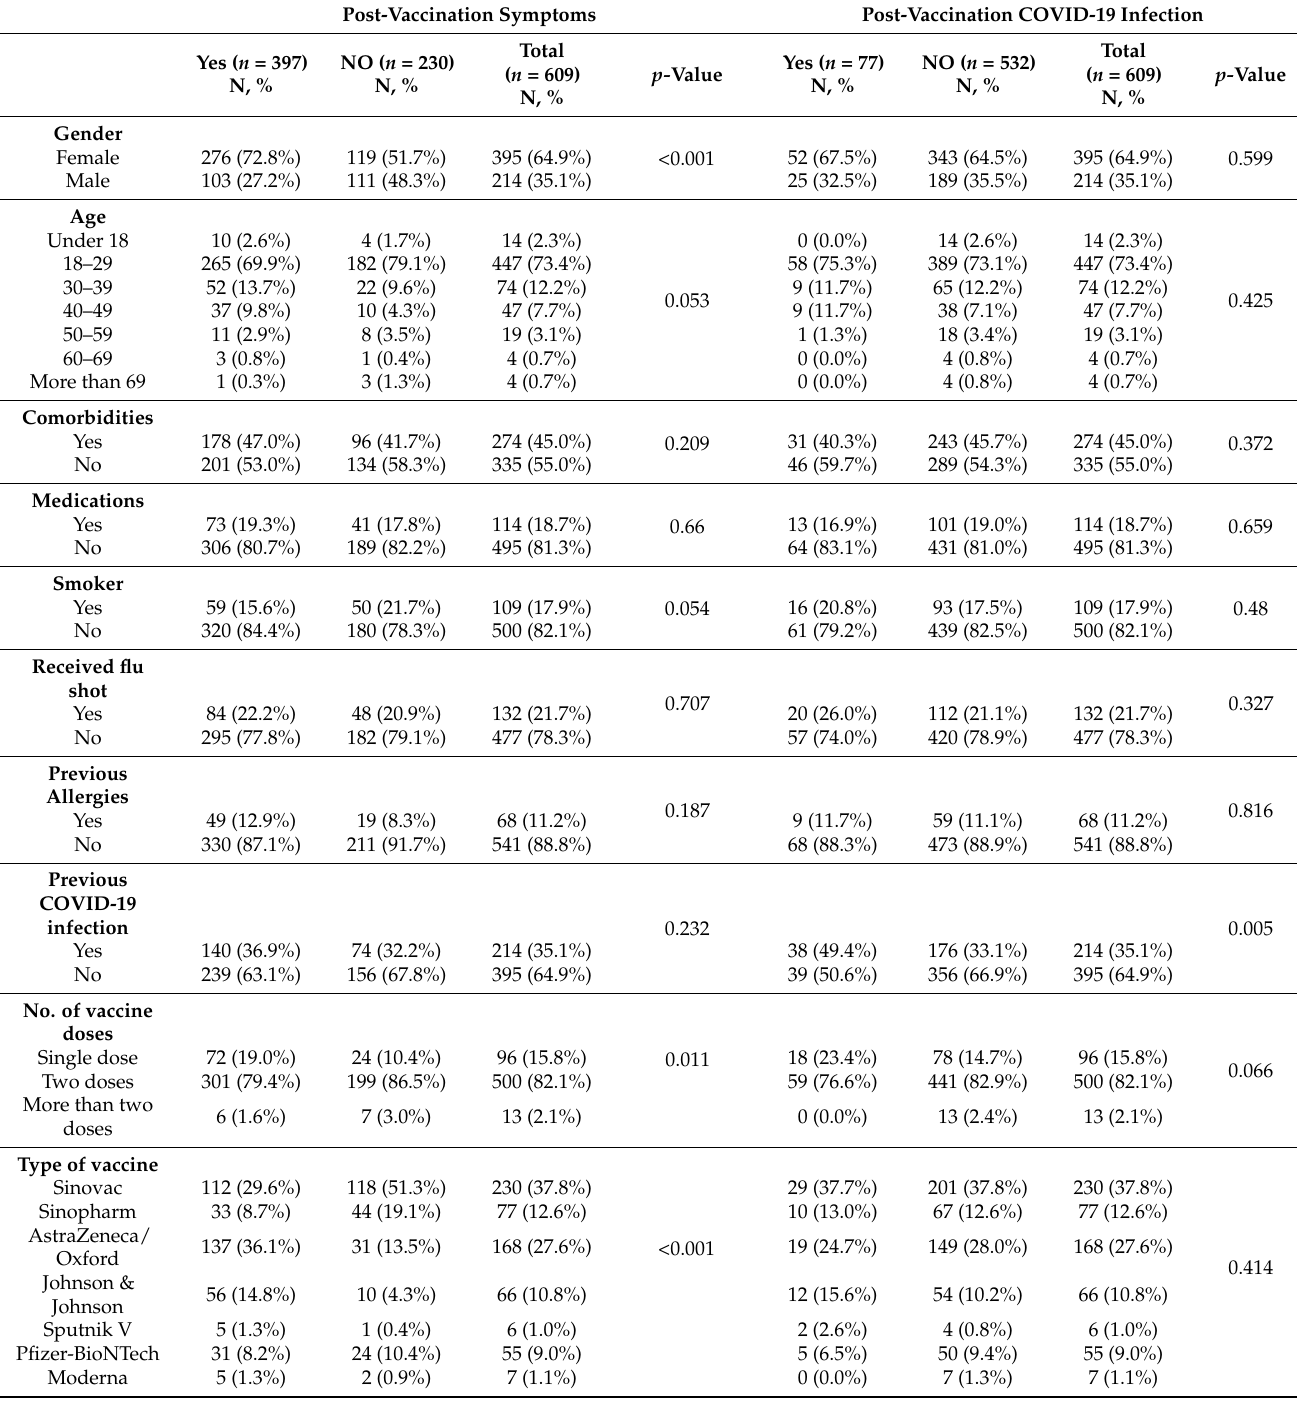
Table 5. Factors associated with post-vaccination symptoms and COVID-19 infection among the participants ( n =